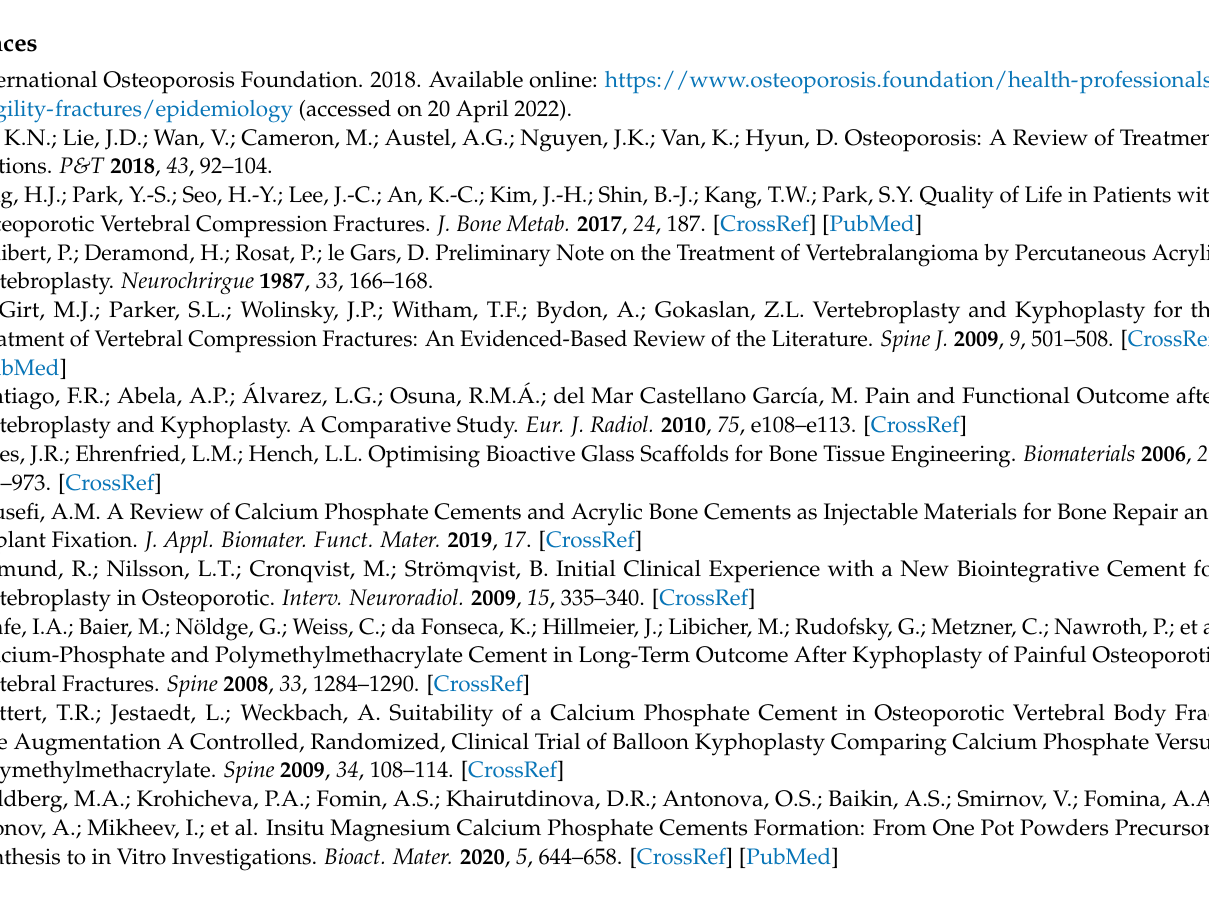
green. Figure S6. Pore size distributions of the investigated cements calculated through individual 3D analyses. Figure S7. Qualitative representations of the pore distribution throughout the cement volumes obtained by using the Micro-CT software. Figure S8. Calcium ion release kinetics from the optimized composite cement formulation with (orange line) and without (blue line)